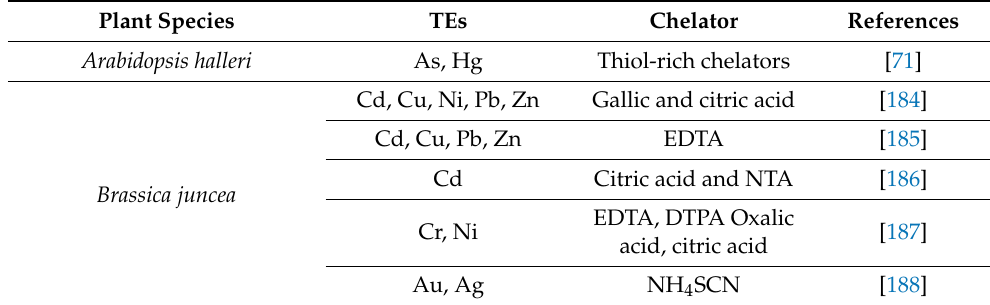
Table 4. Some chelators used in